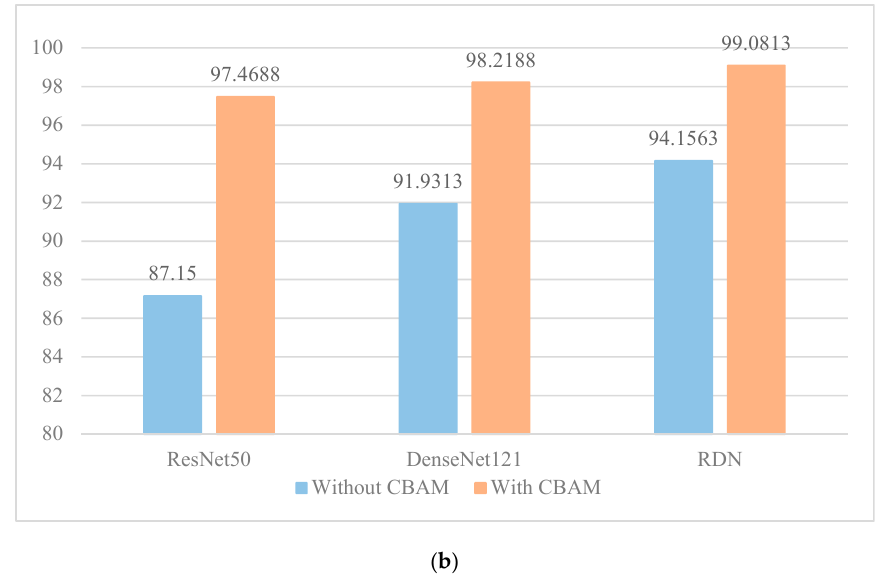
Figure 6. Overall accuracy of ResNet50, DenseNet121, RDN on UCM and AID datasets with and without CBAM: ( a ) UCM dataset; ( b ) AID dataset.